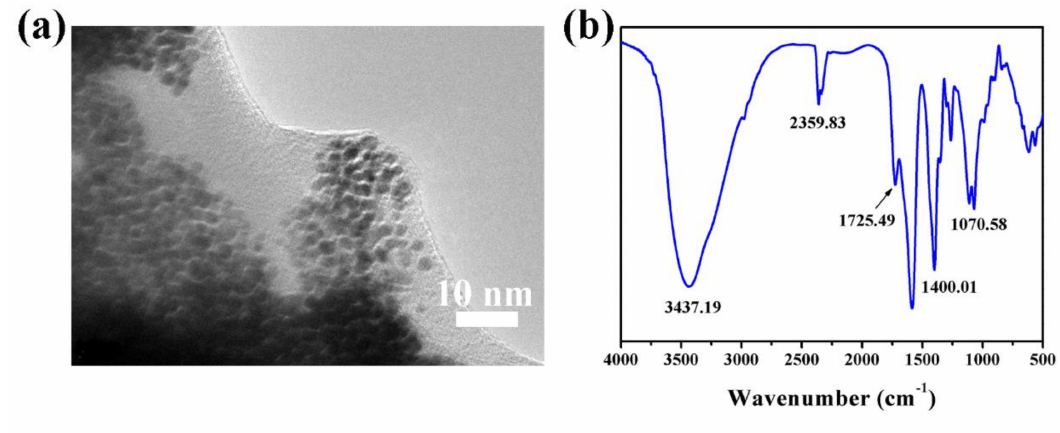
Figure 2. ( a ) TEM image of Au-HET, and ( b ) FTIR spectrum of Au-HET. In Figure 3a, the peaks for Au 4f, S 2p, S 2s, C 1s, and O 1s can be identified at ca. 84, 168, 206, 288, and 532 eV, respectively, in the measurement of X-ray photoelectron spectroscopy (XPS) of Au-HET. To further obtain the details of structures and compositions of Au-HET, the results were studied utilizing XPS-peak-differentiating analysis. The peaks of C 1s are shown in Figure 3b, and the C on XPS is fitted into two peaks centered at 284.8 and 288.3 eV, which are attributed to the C-C/C-H and C-S species, respectively. In addition, we can find the peaks of Au and Au-S from Figure 3c,d. All the results of XPS of Au-HET further indicate that the thiol has connected on the surface of the gold nanoparticles.